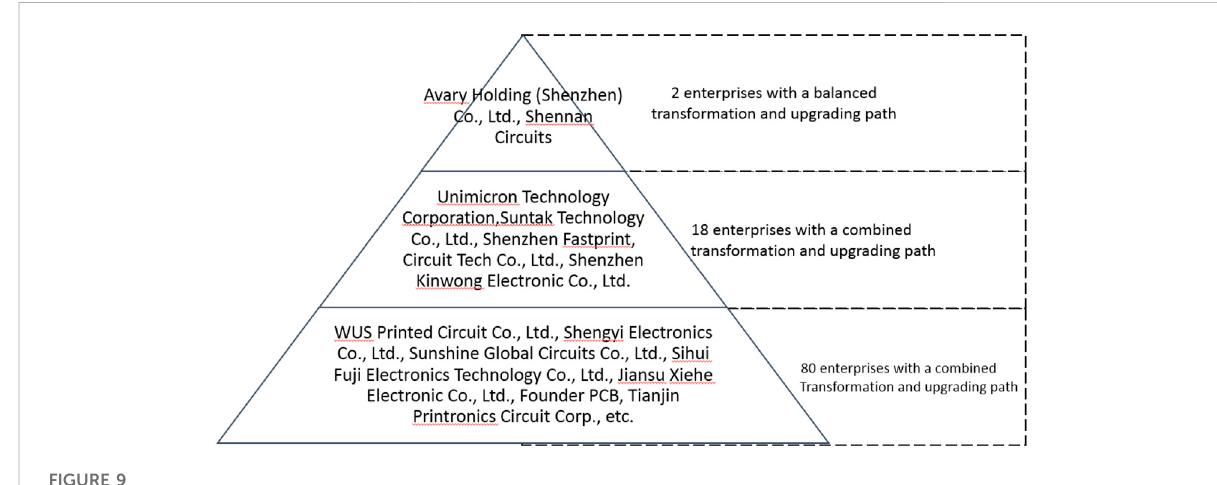
FIGURE 9 Transformation and upgrading path of Chinese electronic circuit enterprises.